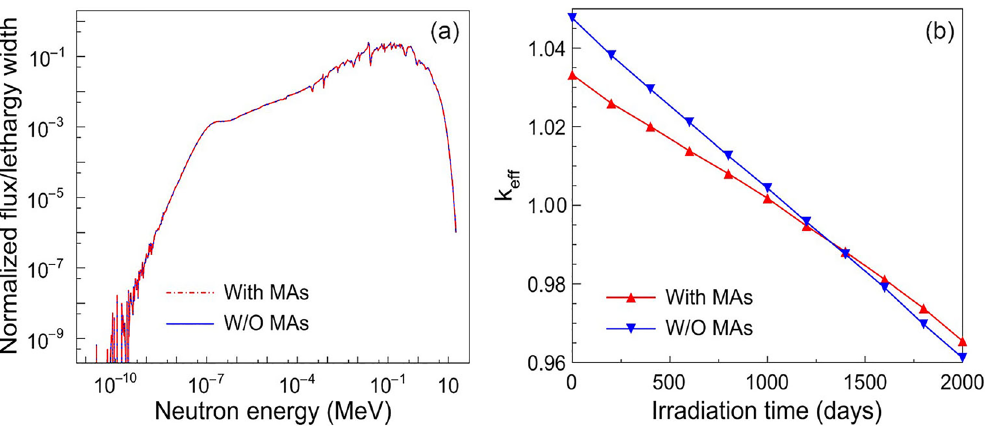
Figure 4. The neutron energy spectrum ( a ) and the evaluation of k eff with time ( b ) at the different loading designs (with and without loading